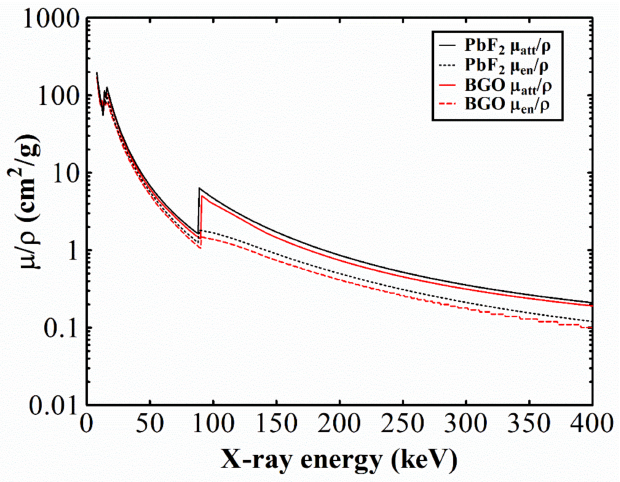
Figure 1. PbF 2 attenuation coefficients. For comparison, data for BGO are also shown.